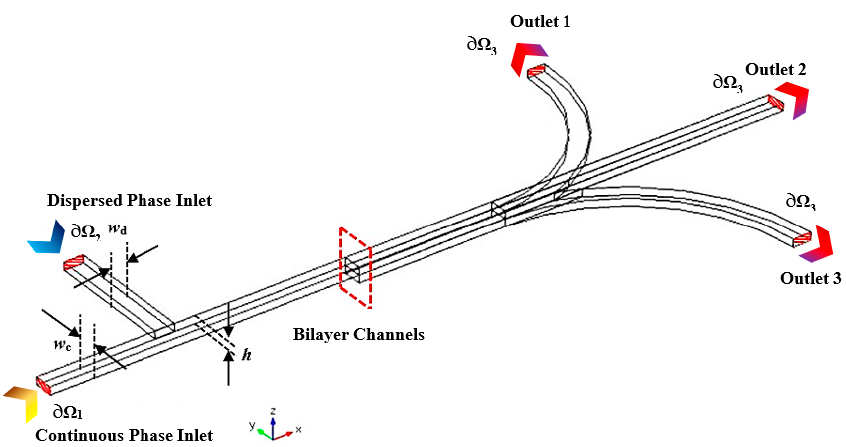
Figure 2. Schematic diagram of double planar microchannel. The droplets are subject to the 3D splitting point at the microchannel downstream where the mother droplets undergo fission and distributed into the trifurcation channels.